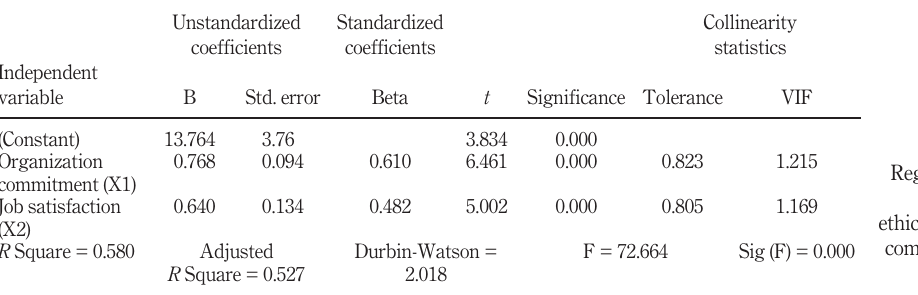
Table IV. Regression analysis